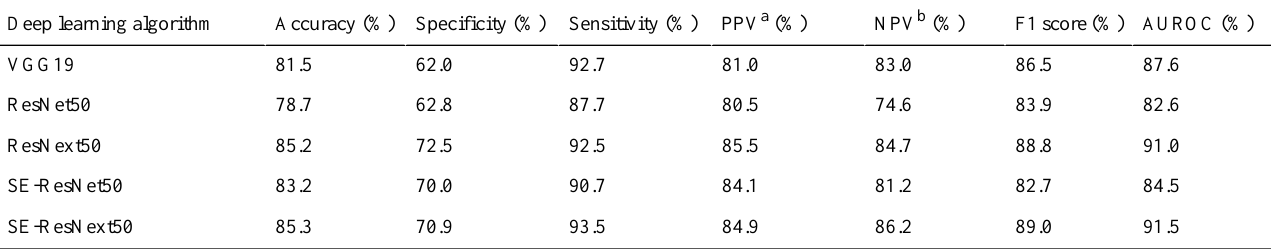
Table 4. Thyroid classification results with conventional deep learning using pooled internal test data.